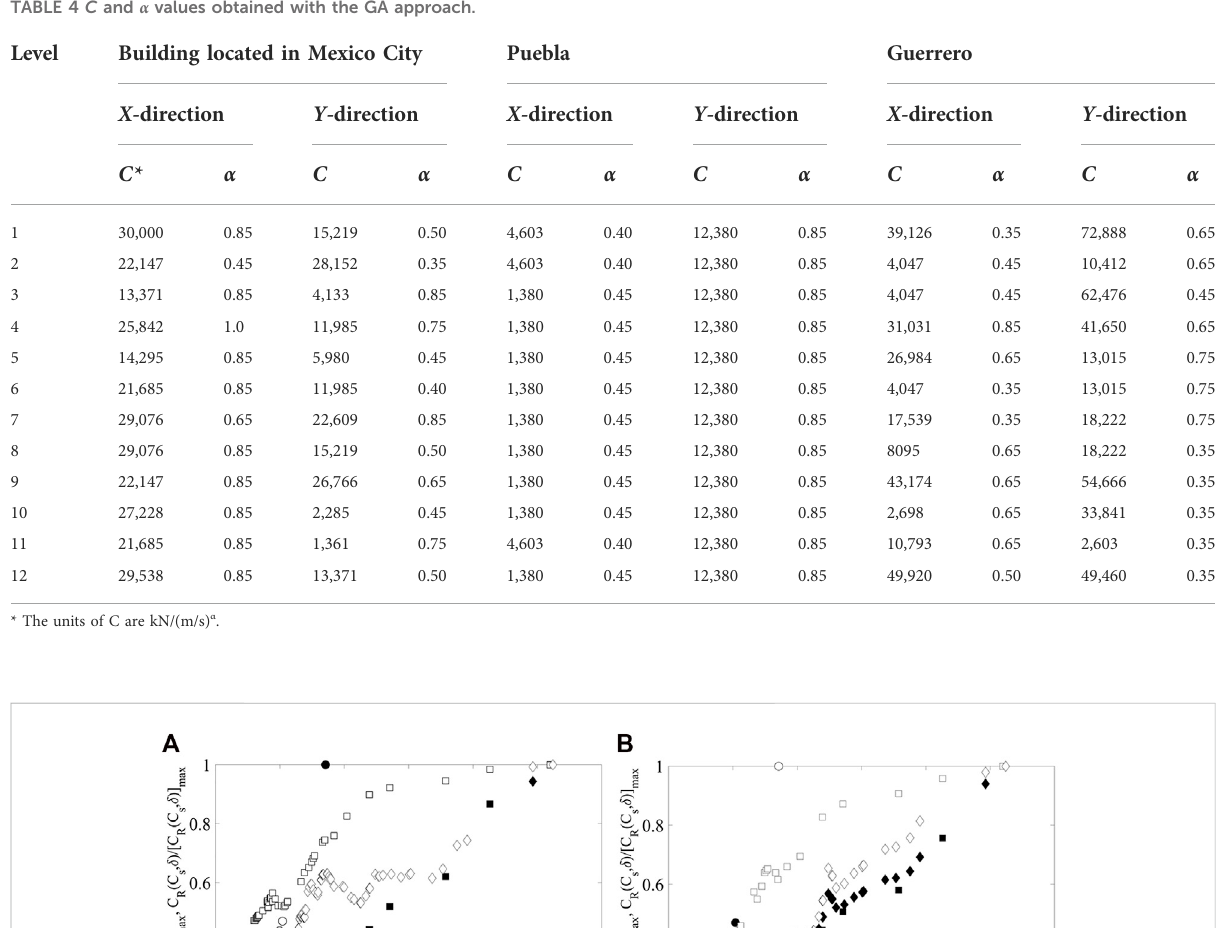
TABLE 4 C and α values obtained with the GA approach.